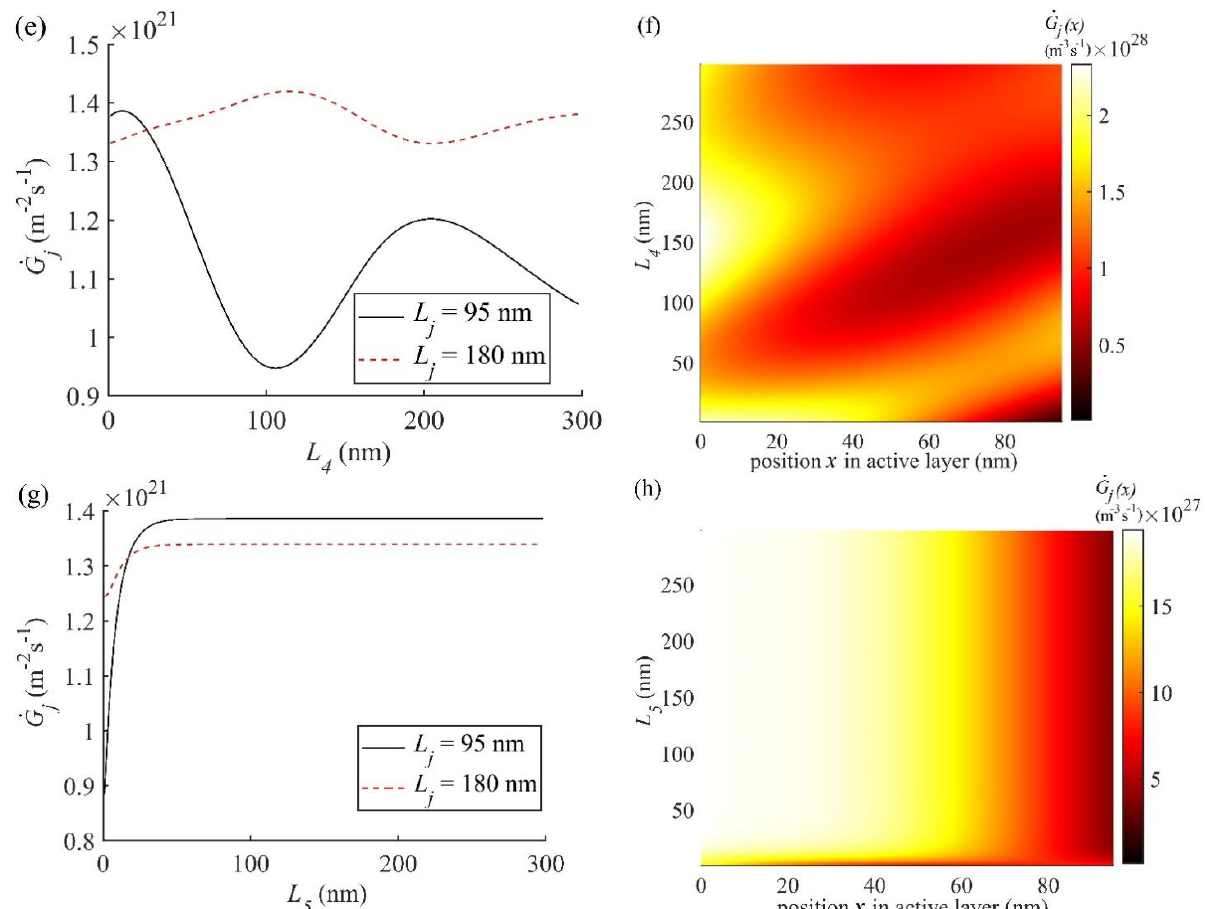
Figure 6. (Left column) 𝐺̇ 𝑗 is plotted for two active layer thicknesses 𝐿 𝑗 = 95 nm and 180 nm, as function of the thickness of ( a ) L 1 of layer 1 (ITO), ( c ) L 2 of layer 2 (ZnO), ( e ) L 4 of layer 4 (MoO 3 ), and ( g ) L 5 of layer 5 (Al). (Right column) Contour plots of 𝐺̇ 𝑗 (𝑥) as a function x within the active layer of optimal thickness 𝐿 𝑗 = 95 nm, for other layers of thickness ( b ) L 1 of layer 1 (ITO), ( d ) L 2 of layer 2 (ZnO), ( f ) L 4 of layer 4 (MoO 3 ), and ( h ) L 5 of layer 5 (Al).